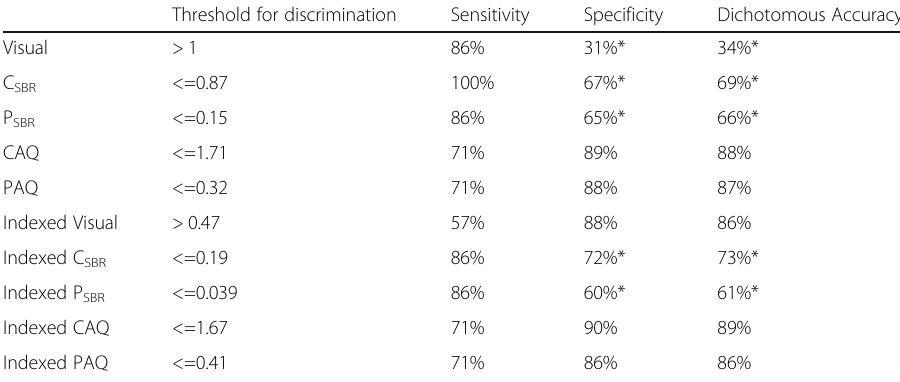
Table 5 ROC result for discriminating patients with DLB from all other patients (i.e., ET, PD and MA) Threshold for discrimination Sensitivity